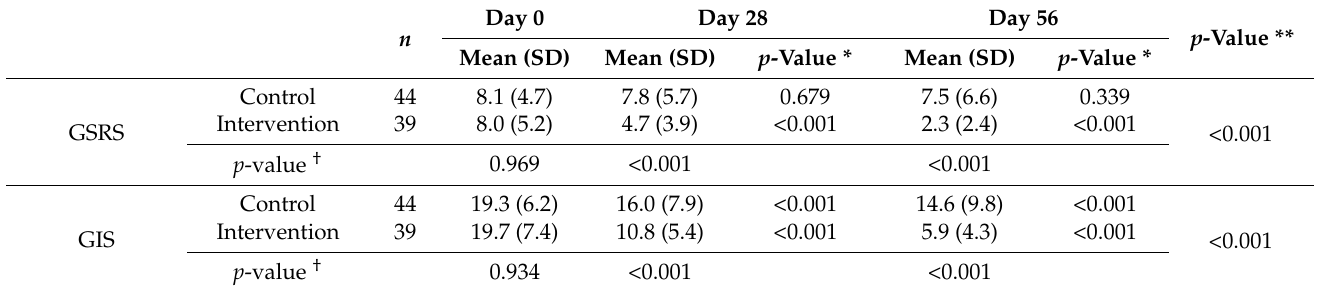
Table 2. Primary and secondary outcomes of this study to evaluate the efficacy of